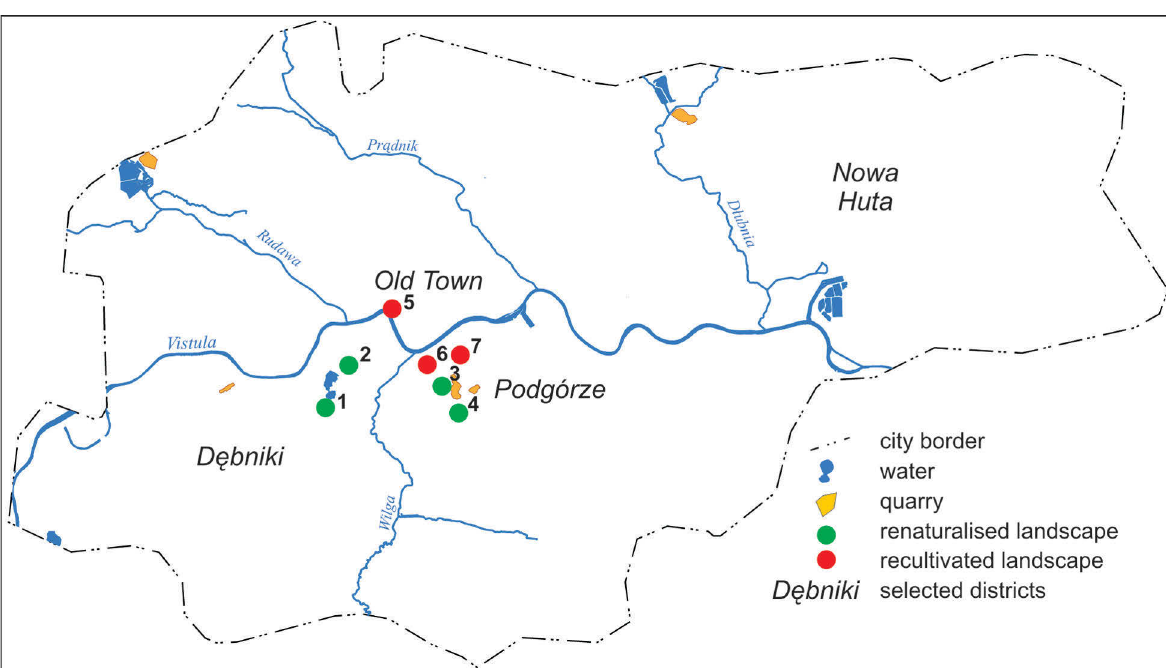
Fig. 2. Location of the selected renaturalised and recultivated landscapes in the City of Kraków: 1 – Zakrzówek Lake, 2 – “Skałki Twardowskiego” quarry, 3 – “Liban” quarry, 4 – “Bonarka” quarry, 5 – breach in the Waw- el hill, 6 – Bednarski Park, 7 – “Pod Św. Benedyktem”